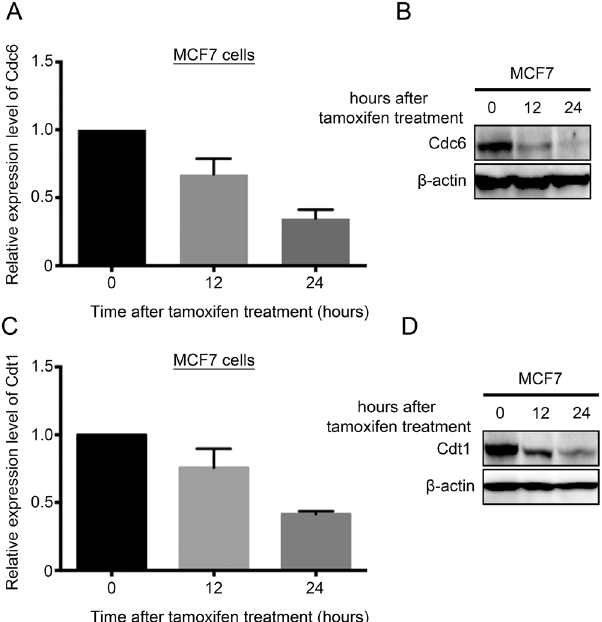
Figure 6. The expression of Cdc6 and Cdt1 upon inhibition of ER signalling. ( A ) Histogram and ( B ) Western blot showing the expression of Cdc6 in MCF7 cells treated with tamoxifen at 0, 12 and 24 hours post-treatment. ( C ) Histogram and ( D ) Western blot showing the expression of Cdt1 in MCF7 cells treated with tamoxifen at 0, 12 and 24 hours